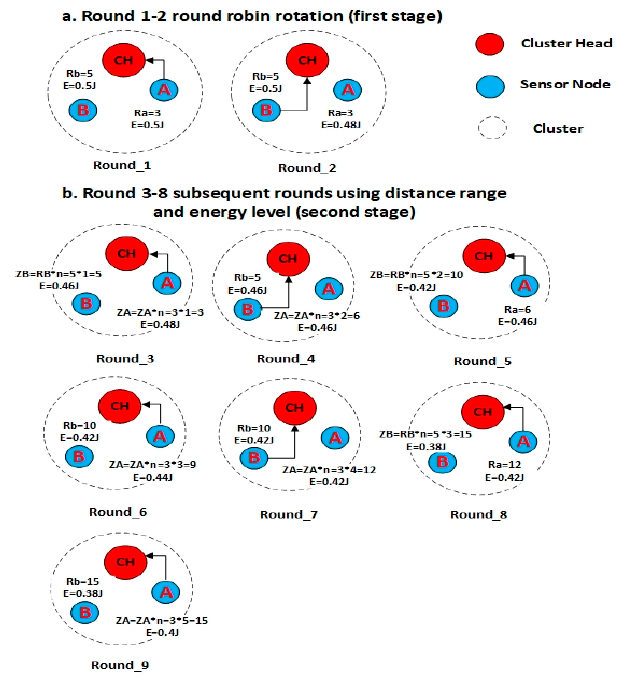
Figure 7. Sleep-awake rotation.